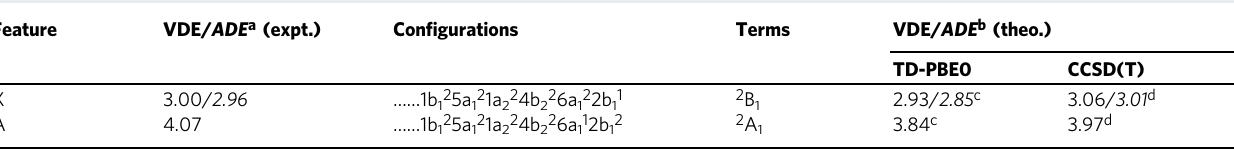
Table 2 The experimental data of PbB 3 O 2 – and their assignments. Feature